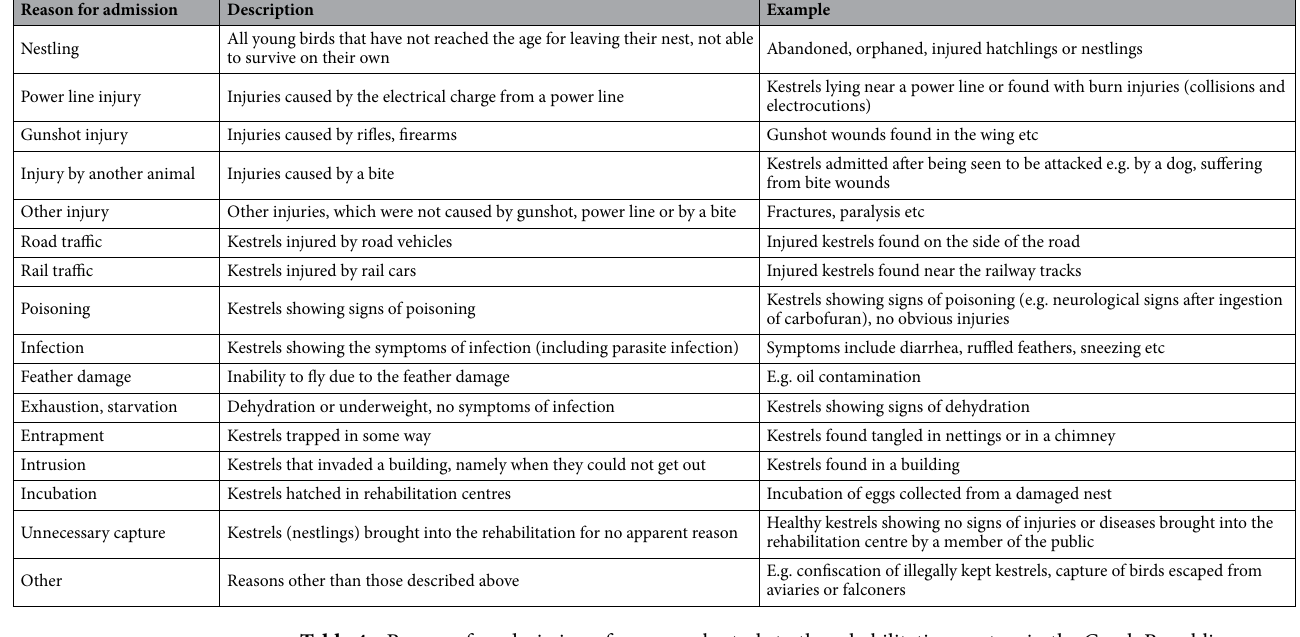
Table 4. Reasons for admission of common kestrels to the rehabilitation centres in the Czech Republic.